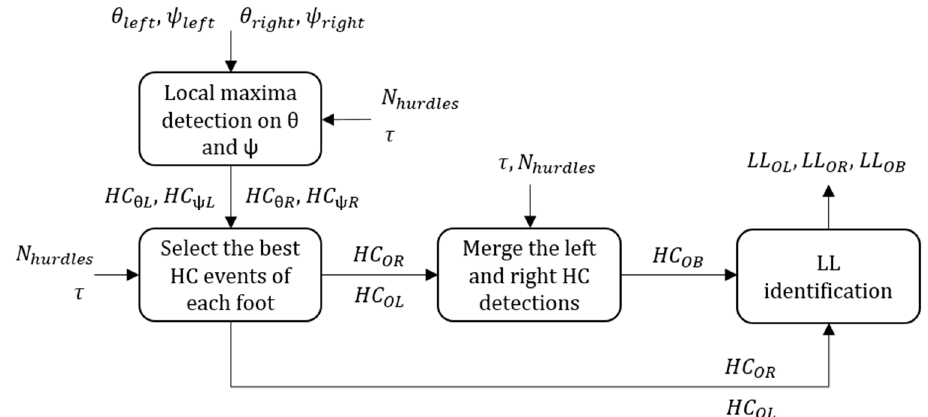
Figure 6. Flow chart of the ORIENT method. In the figure, the pitch and yaw signal are represented by θ left , θ right and ψ left , ψ right , respectively. N hurdles is the number of hurdles to detect and τ the minimum time difference between two consecutive HC. Hurdle clearance (HC) detection results are shown as HC XX and leading leg detection results as LL XX , where XX describes the detection method. For more details about the different HC and LL sets, see the definitions in Section 2.4.3.